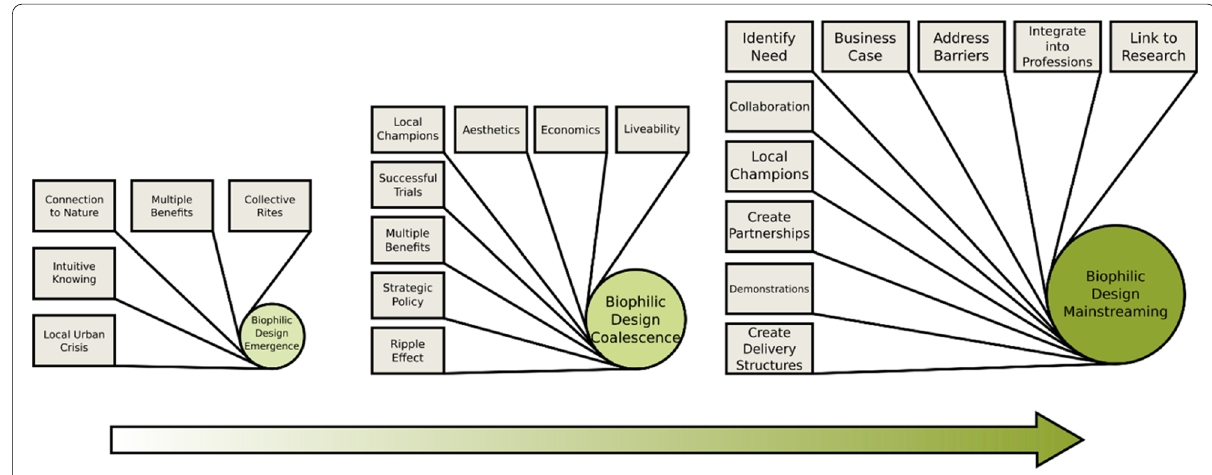
Fig. 5 Biophilic Design social movement journey. (Source